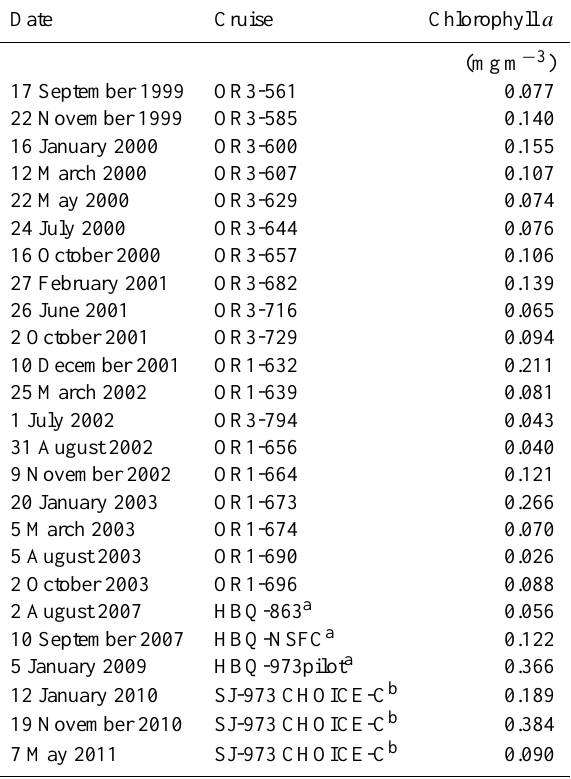
Table 1. Dates of water sampling at the SEATS station on cruises for chlorophyll a analysis and the data that are used to check the remotely sensed sea surface chlorophyll a concentration by